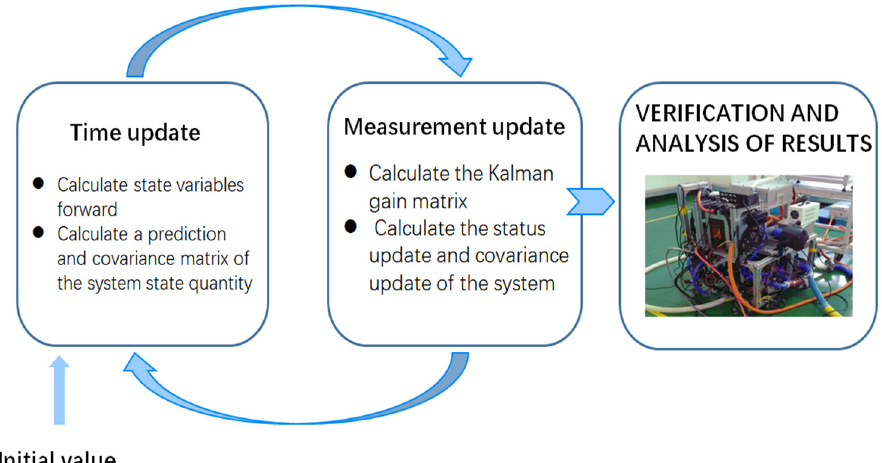
Figure 1. The research content of this